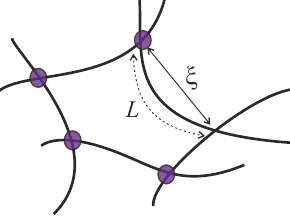
Figure 5. A sketch of a crosslinked filament network, showing the filament contour length L and the end-to-end distance R , which is equivalent to the mesh size ξ used later in the